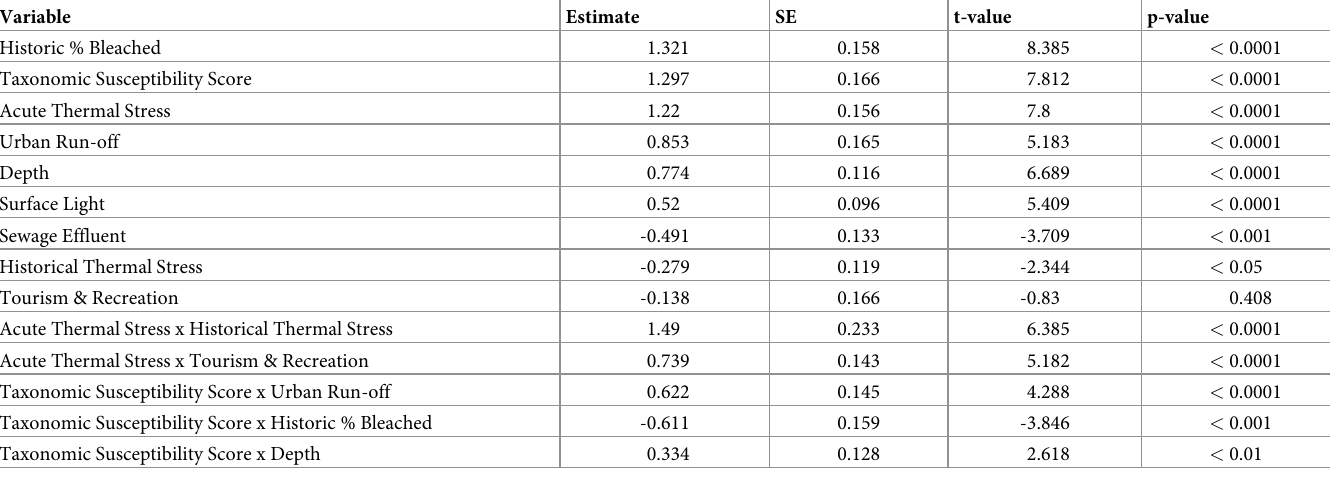
Table 1. Best-fit model for drivers of 2019 bleaching (adjusted R-squared =